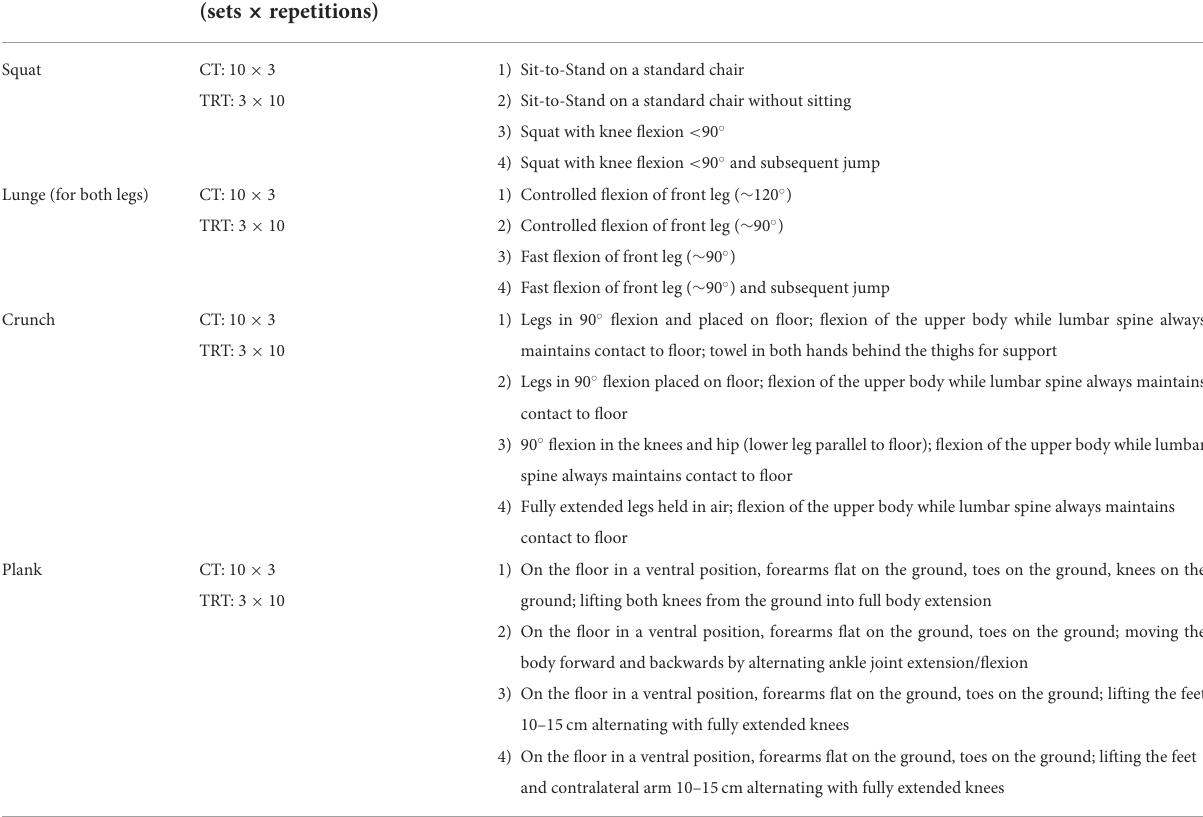
TABLE 2 Six-week training protocol for both training